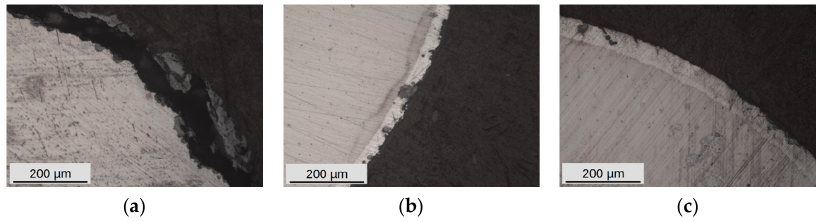
Figure 9. Local zinc loss at 252 days of corrosion: ( a ) Individual steel wire, ( b ) ungreased steel wire, ( c ) greased steel wire.